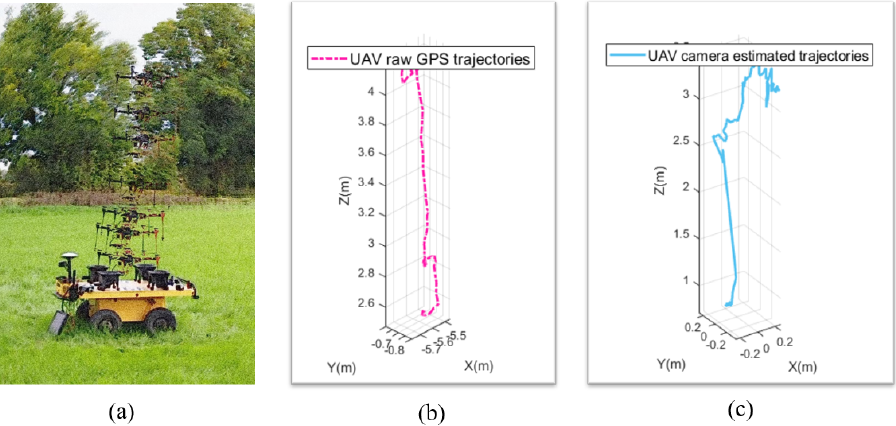
Figure 9. ( a ) Screenshots of a typical landing test conducted in Crippings Farm; ( b ) Raw GPS data of the landing. ( c ) Estimated positions from the visual positioning algorithm.